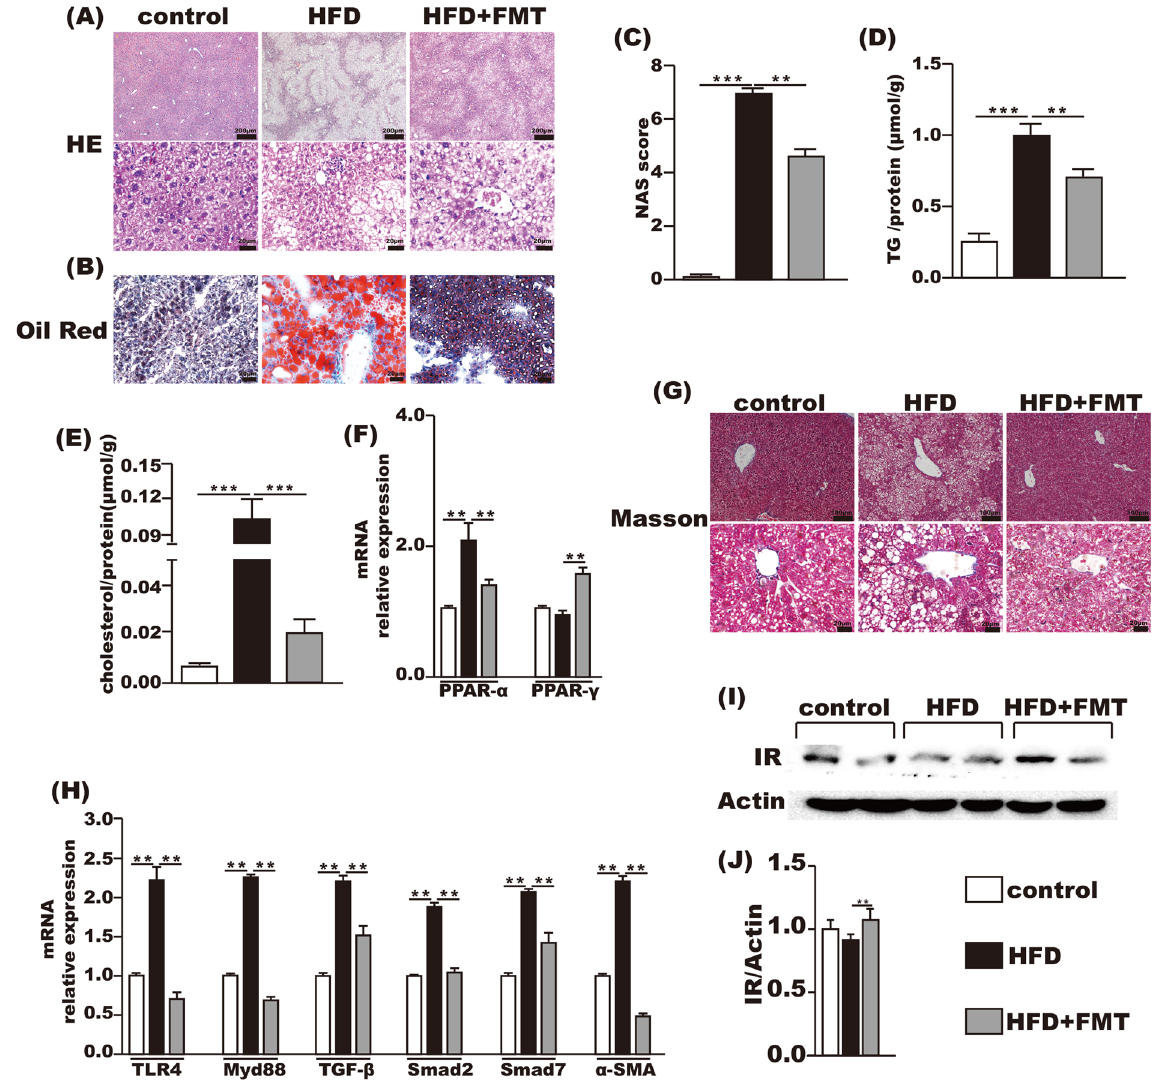
Figure 4. FMT improved inflammation and lipid metabolism in liver. ( A,B ) HE and oil red O staining of liver. ( C ) NAS score. ( D,E ) the level of TG and cholesterol in the liver. ( F ) Lipid metabolism-associated PPAR- α and PPAR- γ gene expression in the liver. ( G ) Masson’s staining. ( H ) Endotoxin-associated gene expression of TLR4 and Myd88 and fibrosis-associated gene expression of TGF- β , Smad2, Smad7 and α -SMA. ( I,J ) IR protein expression level in liver. Gene expression levels are expressed as values relative to the control group. The data represent the mean ± S.E.M. (n = 12 mice per group), * P < 0.05, ** P < 0.01 and *** P <